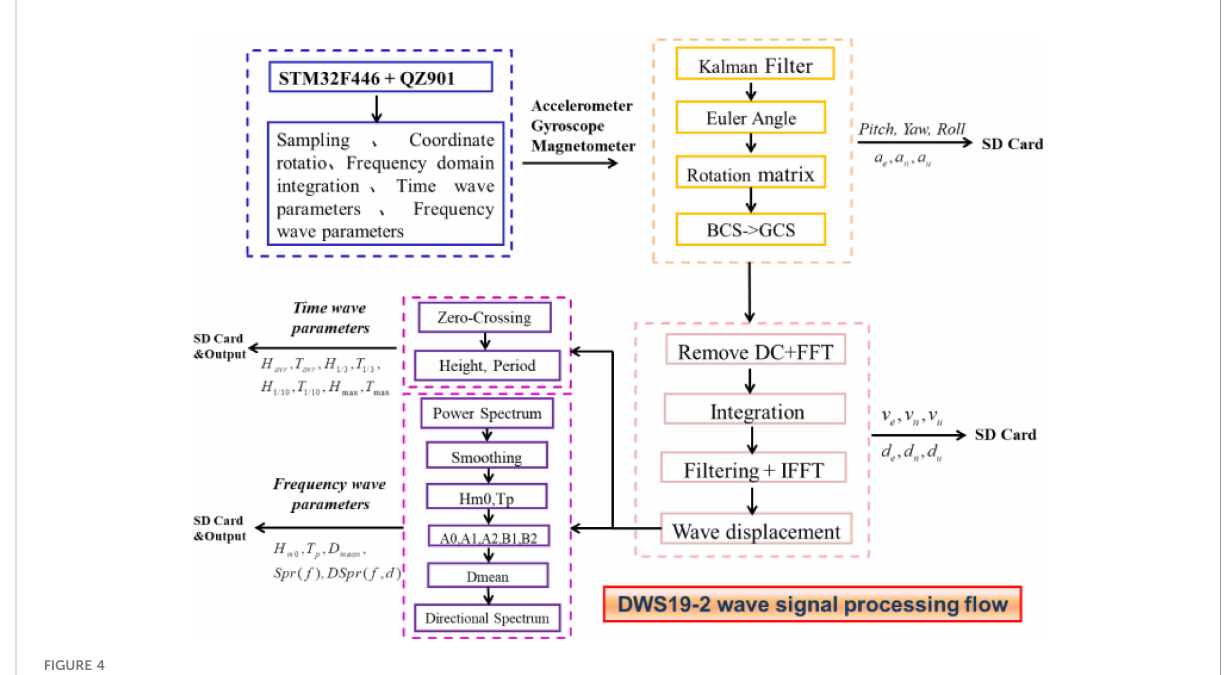
FIGURE 4 DWS19-2 wave signal processing fl